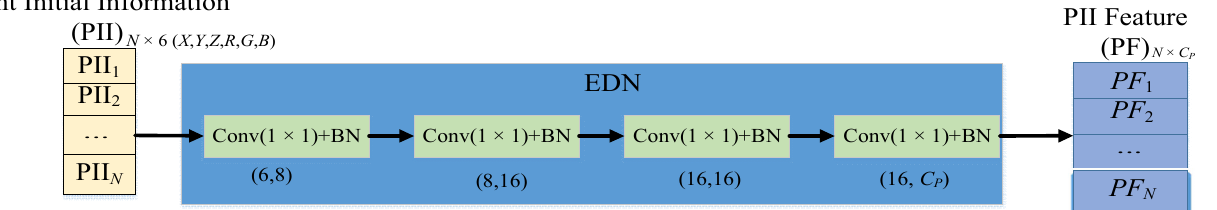
Figure 1. The framework of